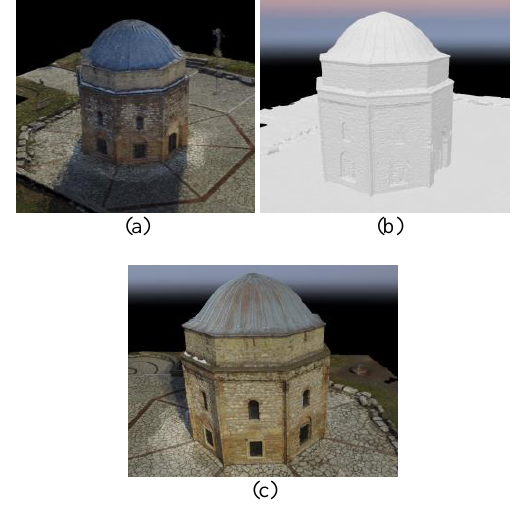
Figure 5. (a) Dense point cloud (b) mesh (c) textured mesh generated in Pix4Dmapper